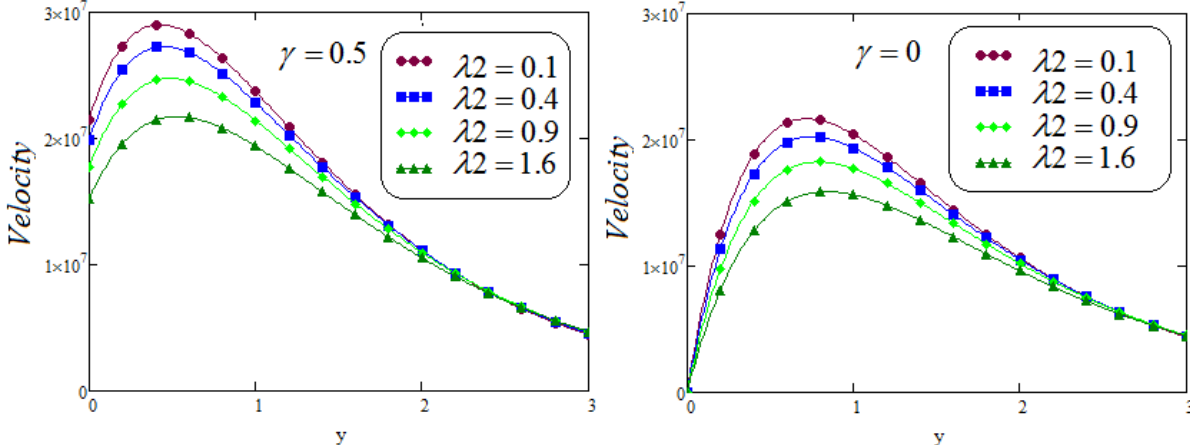
Figure 15. Velocity for varied values of λ 2 with and without slip effect γ when f ( t ) = sint , t = 1.5, α = 0.5, β = 0.3, Gr = 3.5, λ 1 = 0.6, P r = 0.71, M = 2.